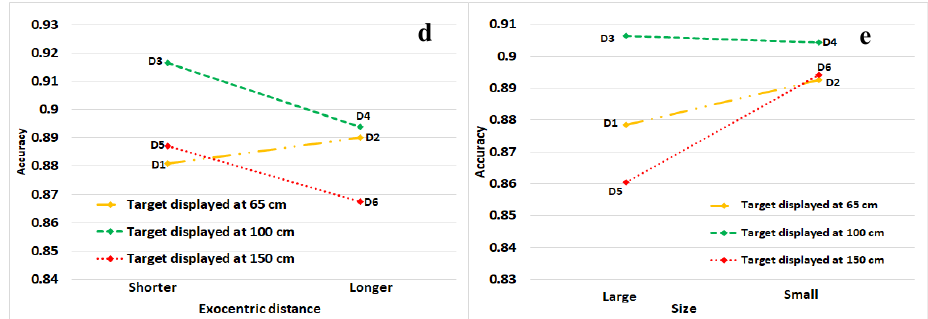
Figure 5. Horizontal position accuracy with respect to exocentric distance for the target displayed at ( a ) 65 cm, ( b ) 100 cm, and ( c ) 150 cm from the participant, where horizontal position accuracies in the SWDs were worsened as exocentric distance increases. Weber’s law could explain the phenomena where the accuracy decreases as exocentric distance increases [4,28]. The main effect of ( d ) exocentric as size and exocentric distance decreases.